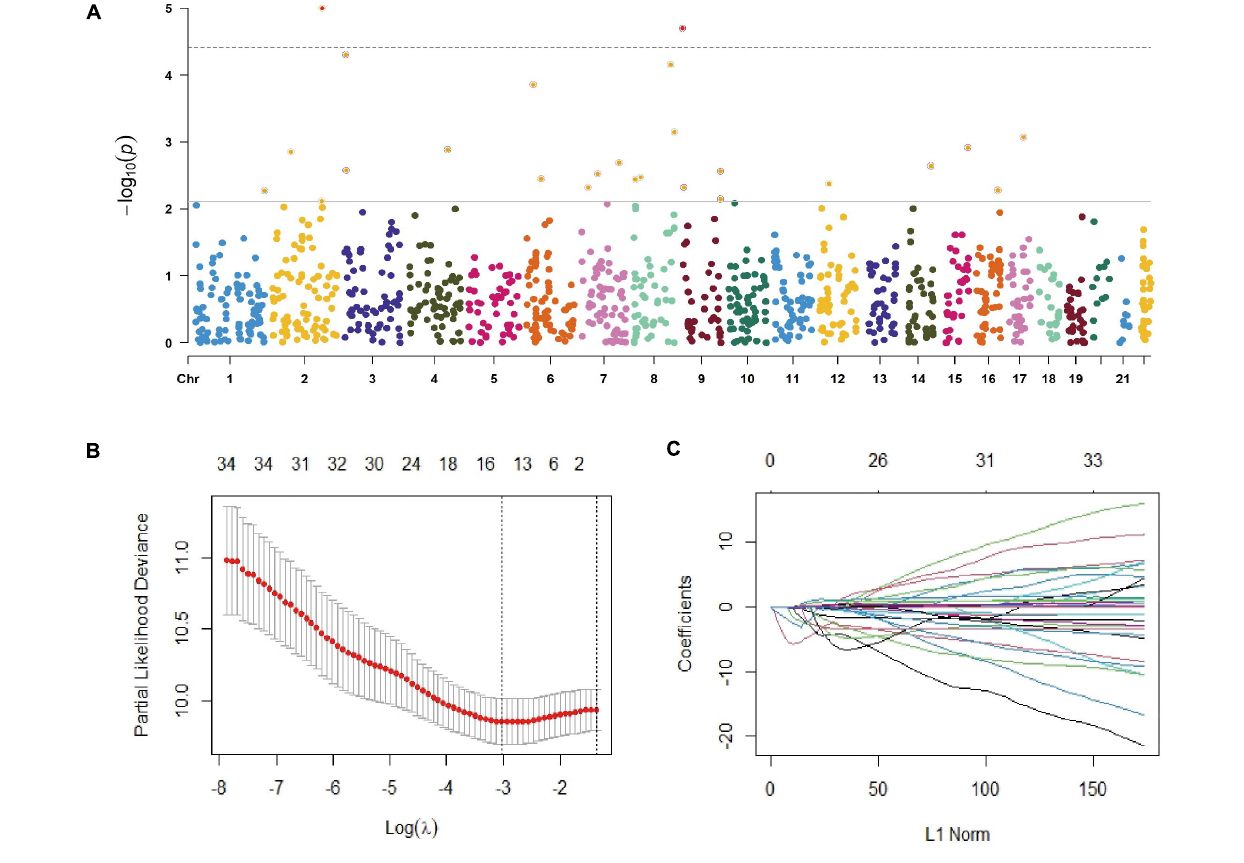
Frontiers in Genetics |